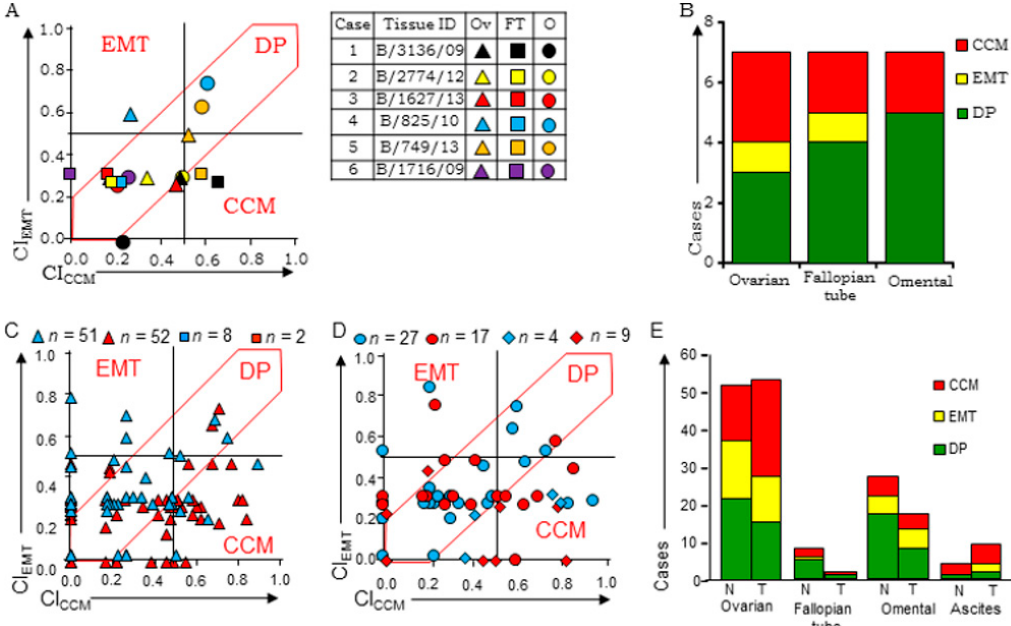
Figure 2. ( A ) Scatter plot of CI CCM vs. CI EMT distribution for chemo-naïve cases with tumors detected in ovary (Ov), fallopian tube (FT), and omentum (O) (left panel), and a reference case-chart (right panel), ( B ) graphical representation of class-specification of Group A tumors, ( C ) scatter plots of CI CCM vs. CI EMT distribution for single chemo-naïve or -treated (red and blue shapes respectively) tumors from-ovary (cid:52) & fallopian tube (cid:3) , ( D ) omentum ◦ and ascites cell blocks , ( E ) graphical representation of Group B tumors (chemo-naïve-N; chemo-treated-T). EMT-epithelial to mesenchymal transition; DP-double positive; CCM-cooperative cell migration.